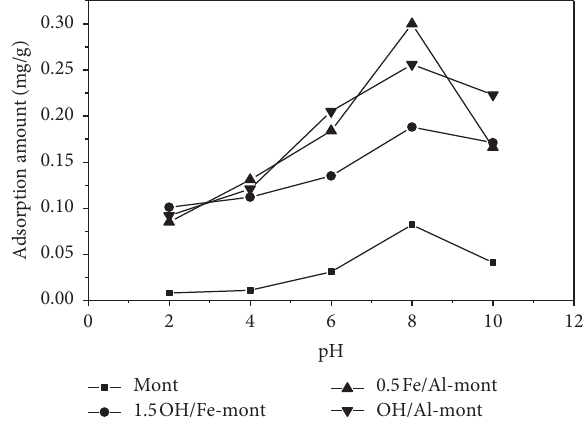
Figure 12: Effect of pH on the ZEA adsorption capacity of Mont.